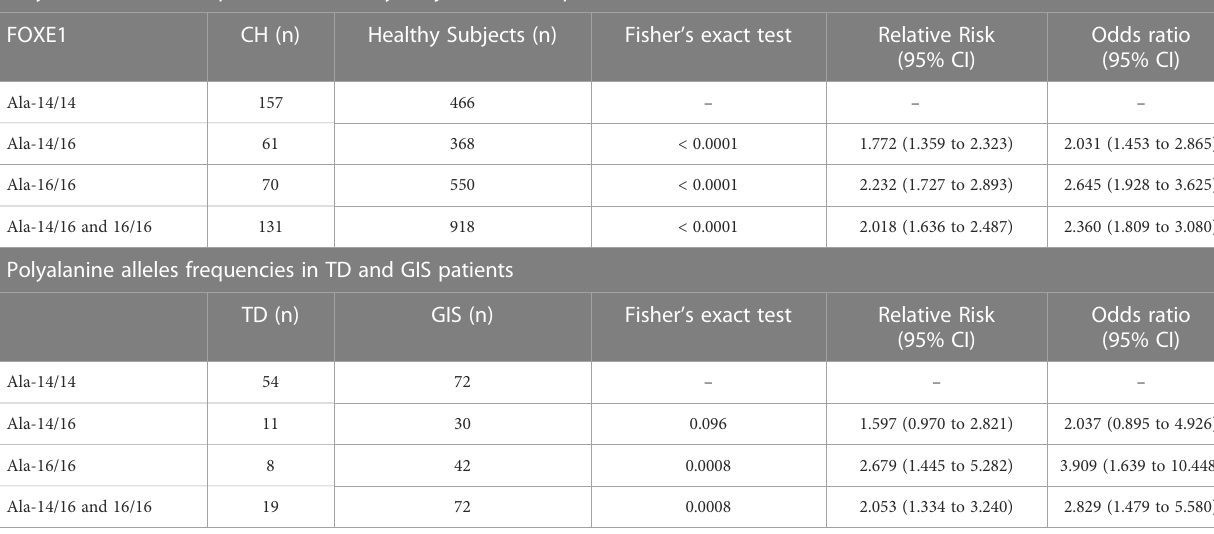
TABLE 2 Association of poly-Ala-FOXE1 isoforms with CH and TD. Polyalanine alleles frequencies in healthy subjects and CH patients